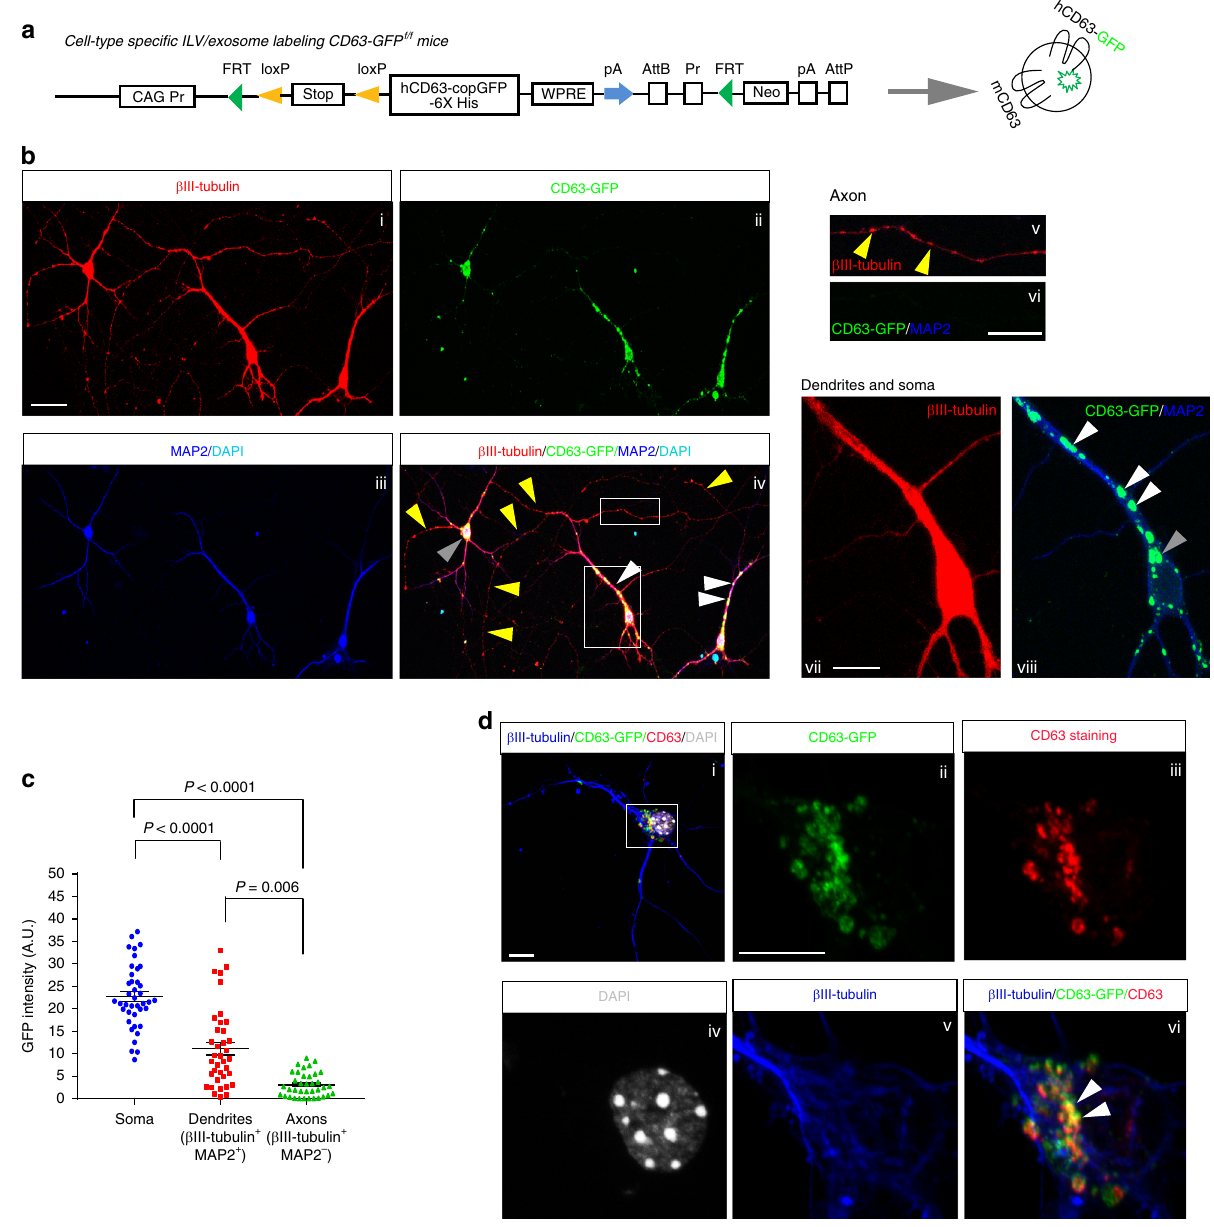
Fig. 1 Compartmental localization of CD63-GFP + ILVs in CD63-GFP f/ + neurons. a Schematic diagram of the gene targeting strategy to insert the CD63- copGFP-6xHis cassette into the Rosa26 locus, in the intron between endogenous exons 1 and 2, for the generation of exosome reporter CD63-GFP f/f mice. copGFP: GFP cloned from copepod Pontellina plumata ; h or mCD63: human or mouse CD63; b Representative images of the distribution of CD63-GFP + puncta in speci fi c compartments of cultured primary neurons. Subpanels i: β III-tubulin staining; ii: CD63-GFP fl uorescence; iii: MAP2 and DAPI staining; vi: merge of CD63-GFP fl uorescence and MAP2 staining; vii: magni fi ed view of β III-tubulin staining. Yellow arrows (subpanels iv and v): axons ( β III-tubulin + MAP2 − ) with sparse overlap of CD63-GFP + puncta; White arrows (subpanels iv and viii): dendrites ( β III-tubulin + MAP2 + ) with abundant CD63-GFP + puncta; Gray arrows (subpanels iv and viii): CD63-GFP + puncta in the soma; Scale bar: 50 μ m; v – viii, magni fi ed confocal images of axons and dendrites taken with the 63x objective lens; c Quanti fi cation of CD63-GFP intensity in the soma, dendrites ( β III-tubulin + MAP2 + ), and axons ( β III-tubulin + MAP2 − ) of cultured primary neurons. n = 40 – 41 neurons/group. P- value was calculated using one-way ANOVA followed by a Tukey post-hoc test. d Representative images of CD63-GFP with endogenous mouse CD63 immunoreactivity. Scale bar: 10 μ m; An anti-CD63 antibody speci fi cally recognizing mouse CD63 was used. The magni fi ed view of the CD63-GFP + neuron (subpanel i) with each channel (as indicated near the image) is shown in ii – vi, respectively. white arrows: overlapped CD63-GFP with endogenous CD63